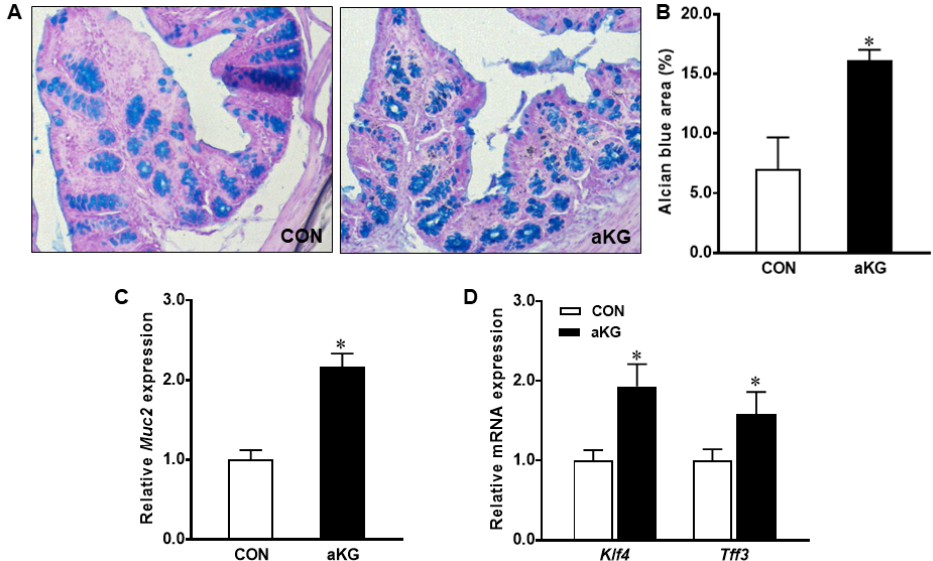
Figure 4. Goblet cells in dextran sulfate sodium (DSS)-induced colitis mice supplemented with or without alpha-ketoglutarate (aKG). ( A ) Representative Alcian blue staining; ( B ) Goblet cell density; ( C ) mRNA expression of Muc2 ; ( D ) mRNA expression of goblet cell differentiation markers. CON: control mice without aKG; aKG: mice receiving 1% aKG; Mean ± SEM, n = 4–7 mice per group. *: p < 0.05.